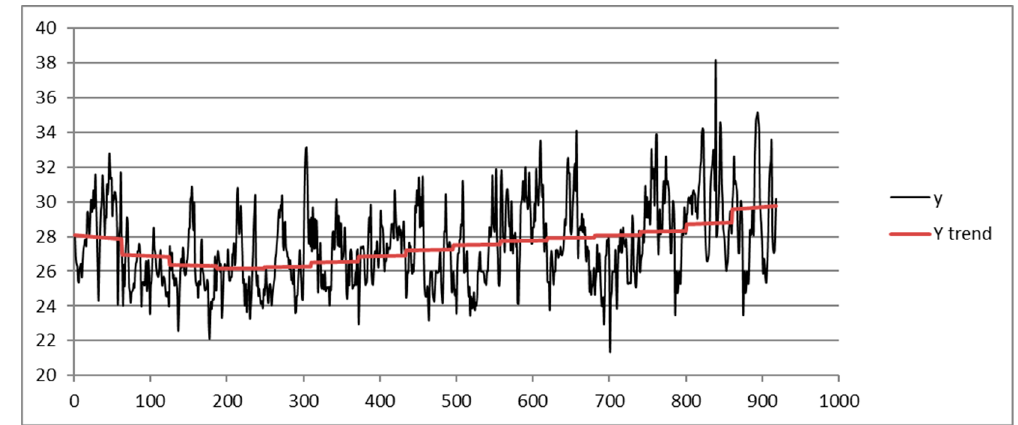
Figure 2. Trend of the heat index (HI) in the months of July and August (from 1 July 2003 to 16 August 2017) obtained from the Napoli Capodichino station dataset by using a ninth-degree polynomial fitting.